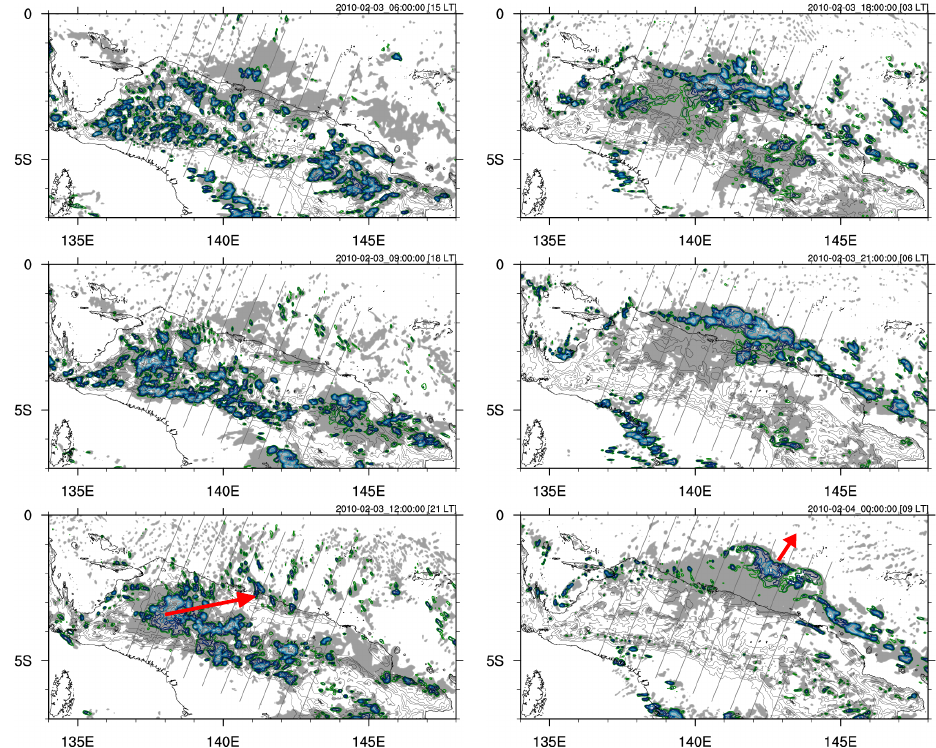
Figure 9. Multi-stage evolution of offshore squall-line propagation for a modelled storm on 3 February 2010, as shown by total column cloud (grey shade) and rainfall (green-blue contours) during the early evening (left panels) and early morning (right panels). The red arrows indicate the approximate direction of storm motion over land and